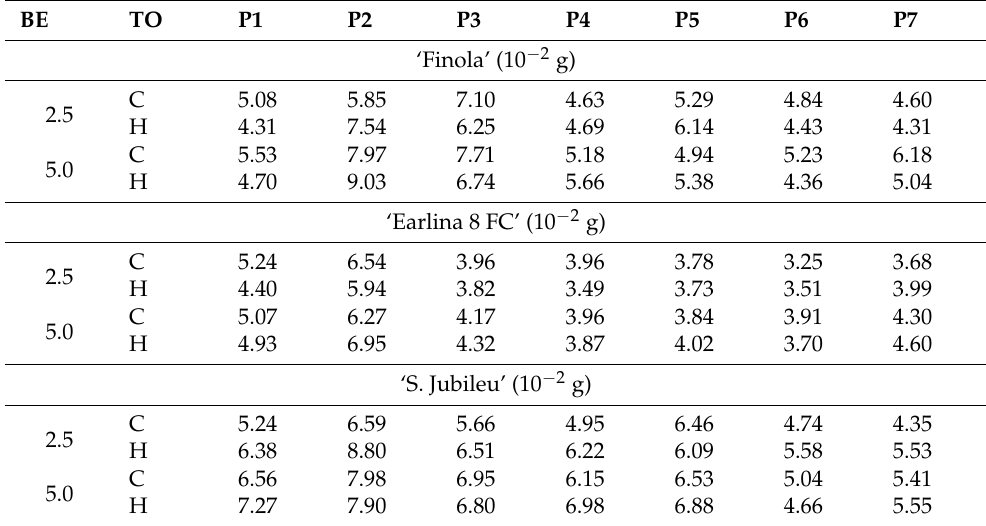
The result of the methanol extraction was a small amount of condensed substance with a dark green color. Table 5 shows the mass of extract extracted from 100 g of hemp oil. Table 5. Weight of extract after methanol extraction. BE